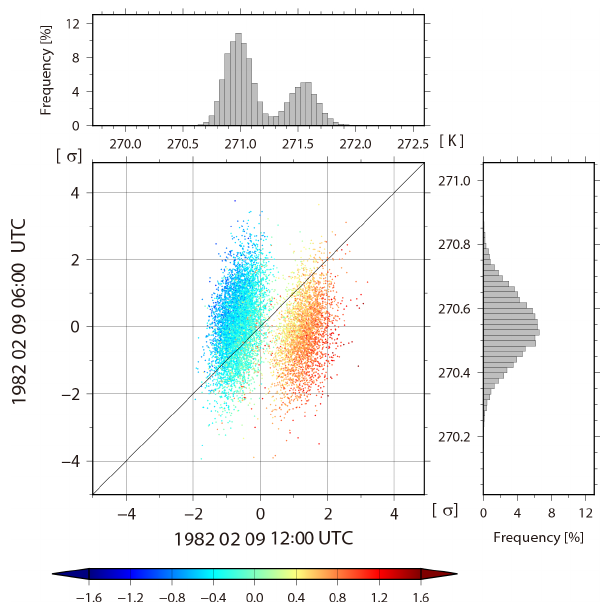
Figure 10. Life cycle of non-Gaussianity at 1.9 ◦ N, 168.7 ◦ E. (a) Trajectories of 256 randomly chosen members from 10240 members for d θ e (see text for definition) from an analysis at the 157th analysis cycle (00:00UTC, 9 February) to forecast the 161st analysis cycle (00:00UTC, 10 February). The colors show the or- der of d θ e for every analysis. D KL shows KL divergence for d θ e , and the superscripts a and f indicate analysis and forecast, respec- tively. (b, c) Spatial distributions of KL divergence for background temperature at the fourth model level ( ∼ 500hPa) at the 158th anal- ysis cycle (06:00UTC, 9 February) and the 159th analysis cycle (12:00UTC, 9 February), respectively. The cross shows the loca- tion of the point considered in panel (a) .